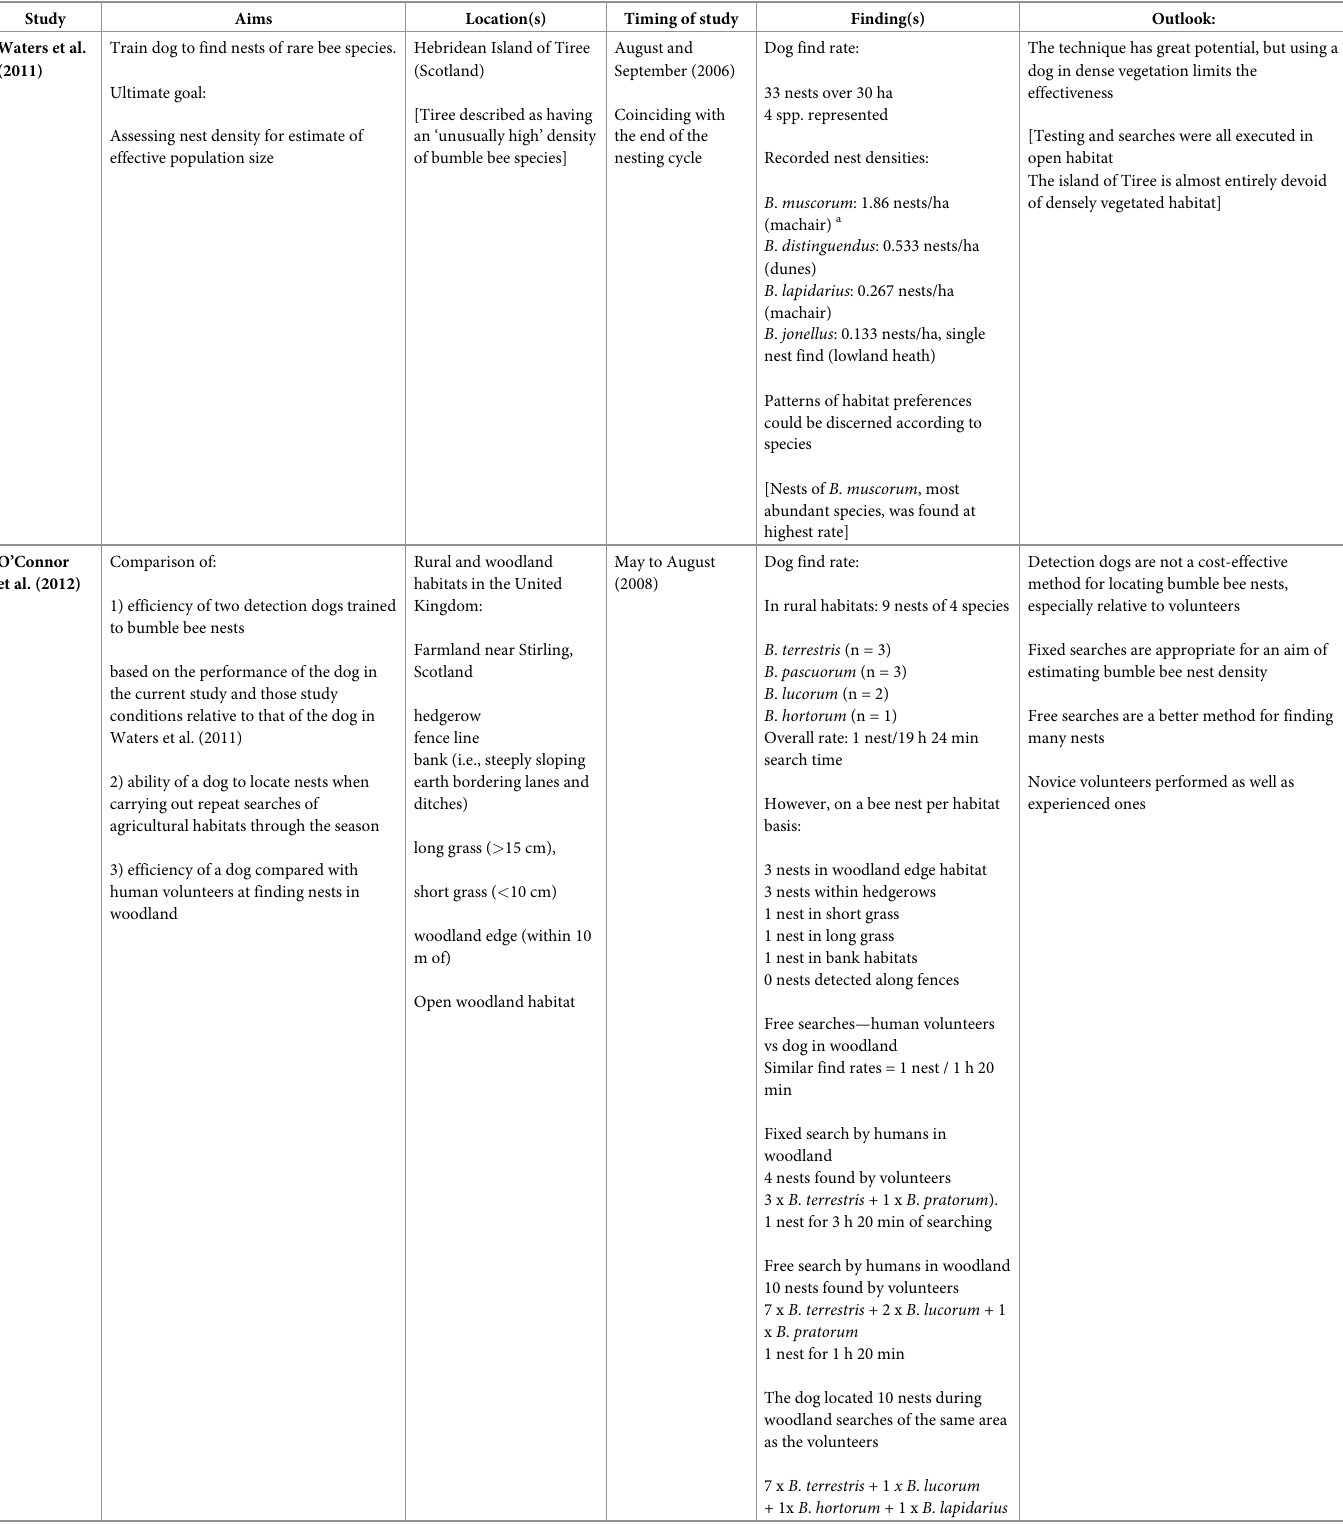
Table 3. Summary of study aims, parameters, findings and outlooks from prior published bumble bee nest detection dog work.